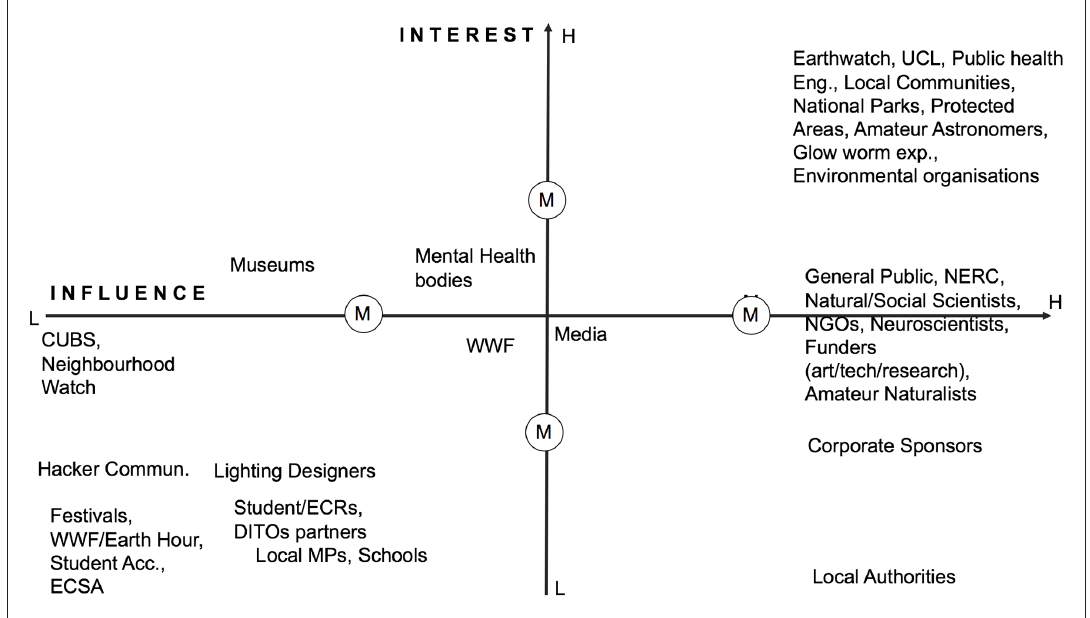
Figure 1: ITN stakeholder mapping result showing stakeholders grouped by their levels of interest (y axis) and influ- ence (x axis). Participants identified three levels of interest and influence: high (H), medium (M), or low (L). On the right-hand side of the graph, stakeholders include those who already exist and contribute to the ITN project (existing contributors); on the left side they inlclude those who should be involved in the project (potential contributors). For example, “Mental Health Bodies” as potential contributors may have a high influence and interest in the ITN project. “Local authorities” are existing contributors and have a low interest but high influence in the project.